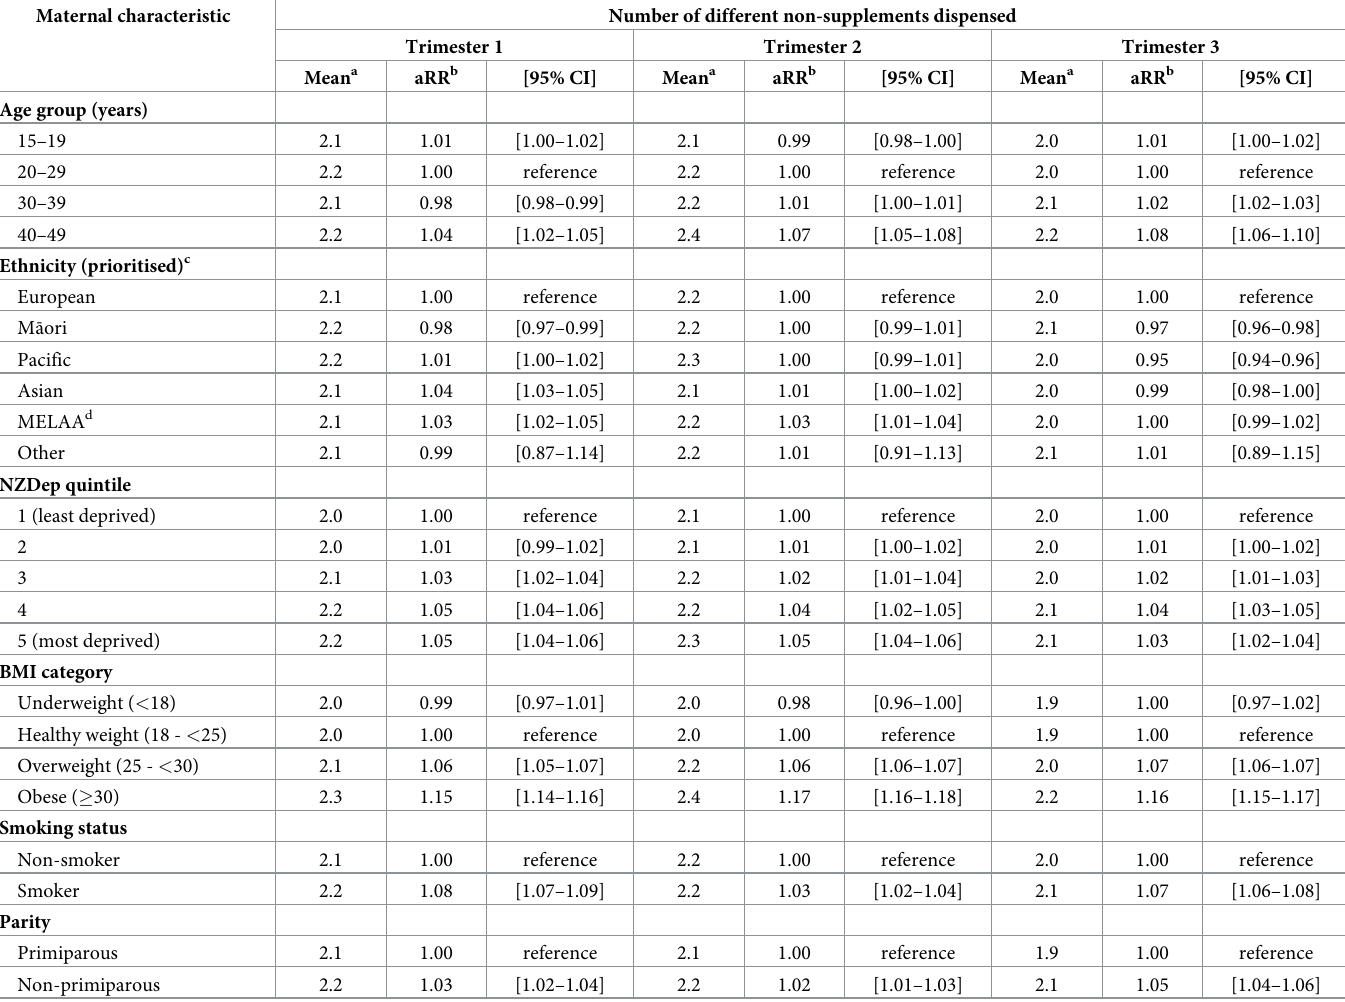
Table 4. The number of different non-supplement prescription medicines dispensed during each of the pregnancy trimesters, by maternal